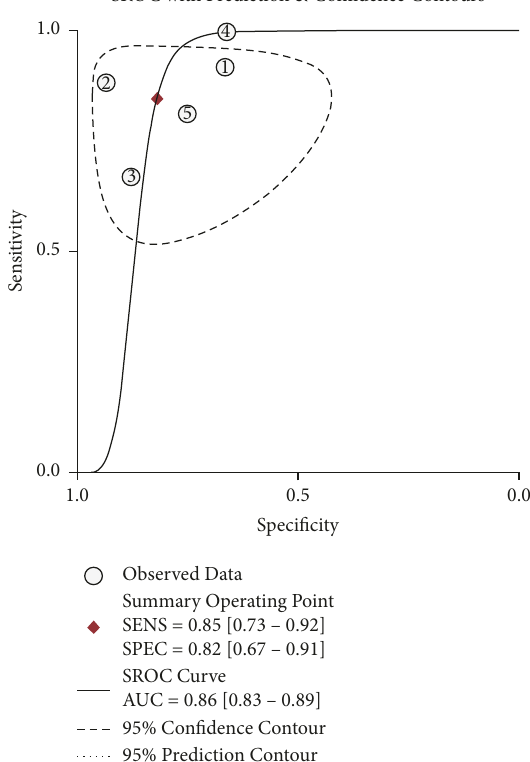
Figure 6: Summary ROC(SROC) curves ofthe diagnostic efficacy of the Cho/Cr ratioof the radiationinjury groupandthe recurrentglioma group.